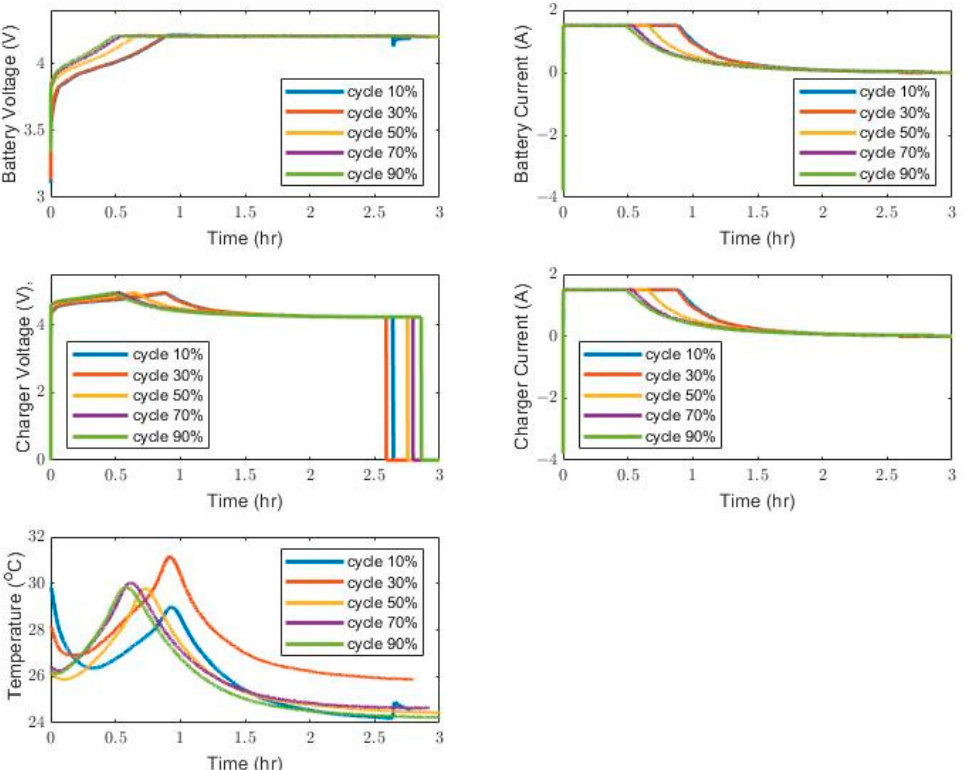
Figure 5. Feature variations in the charging stage related to cycles.